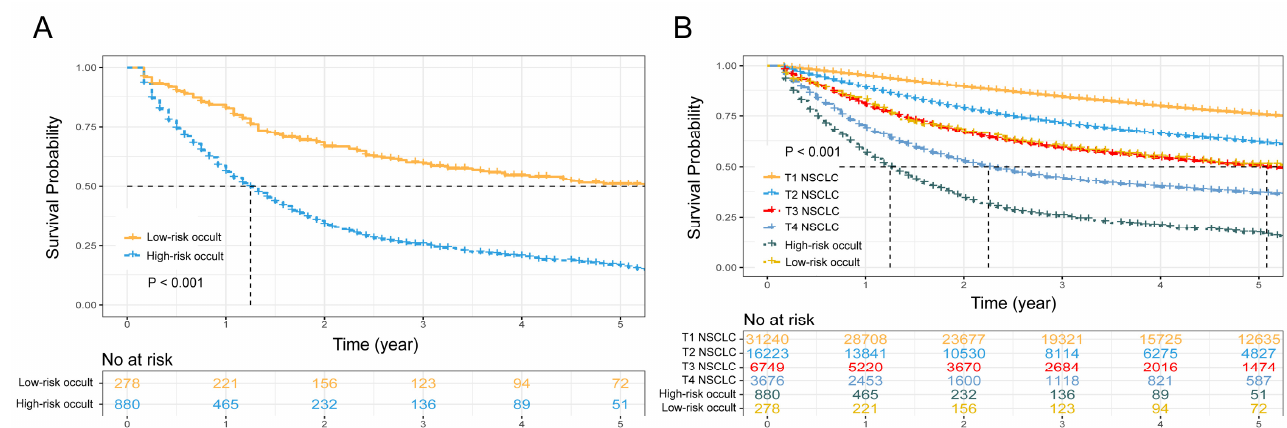
Figure 5. The overall survival comparisons. Low-risk occult NSCLC vs. High-risk occult NSCLC ( A ) and Low-risk occult NSCLC vs. High-risk occult NSCLC vs. T1 stage NSCLC vs. T2 stage NSCLC vs. T3 stage NSCLC vs. T4 stage NSCLC ( B ). NSCLC, non-small cell lung